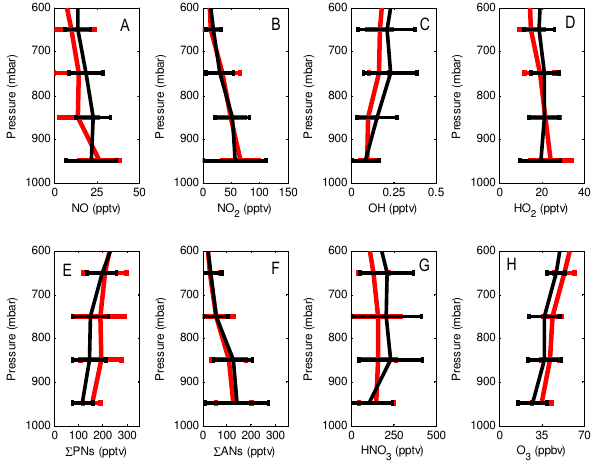
Fig. 2. Mean concentrations binned by altitude of (red) ARCTAS Figure 2 Mean concentrations binned by altitude of (red) ARCTAS observations and (black) 2 observations and (black) WRF-Chem sampled along the flight track WRF-Chem sampled along the flight track for a) NO, b) NO 2 , c) OH, d) HO 2 , e) Σ PNs, f) Σ ANs, 3 for (a) NO, (b) NO 2 , (c) OH, (d) HO 2 , (e) 6 PNs, (f) 6 ANs, (g) HNO 3 , and (h) O 3 . ARCTAS observations are averaged to the res- g) HNO 3 , and h) O 3 . ARCTAS observations are averaged to the resolution of WRF-Chem. 4 olution of